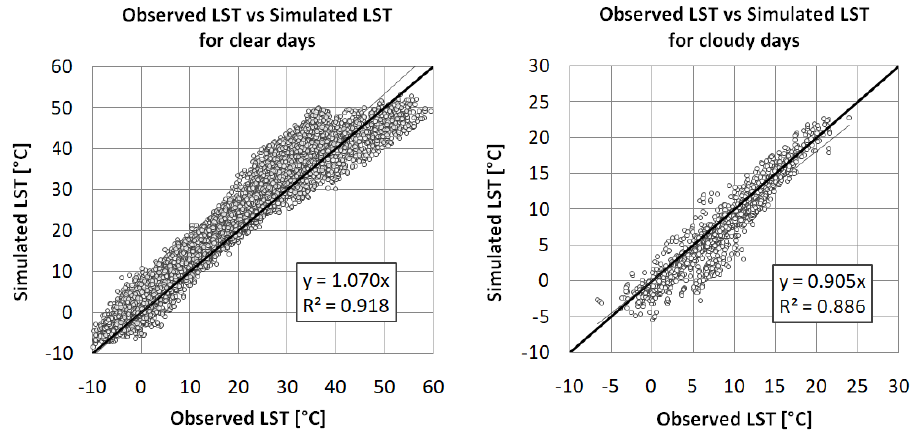
Figure 5. Scatterplot between observed vs. simulated LST over the “Linate” station point during clear (left) and cloudy (right) sky days.